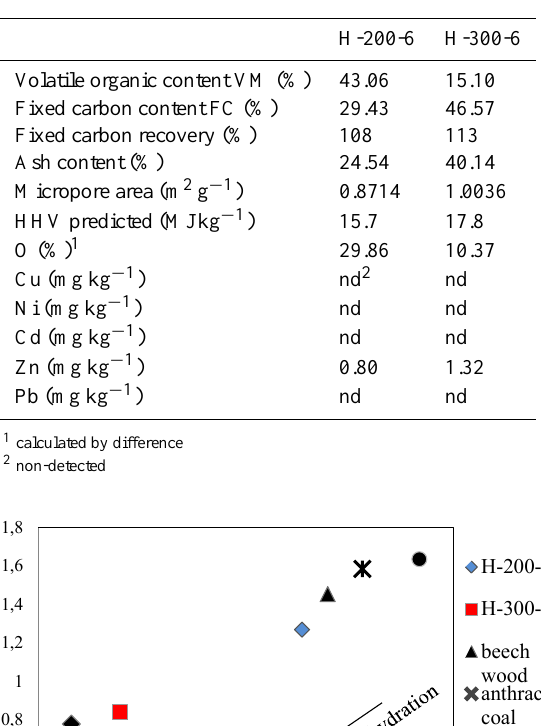
Table 3. Properties of hydrochar samples H-200-6 and H-300-6.